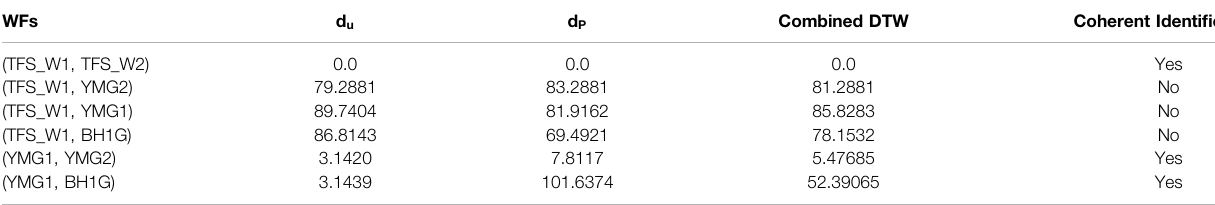
TABLE 3 | Results of combined DTW distance in Group 5.